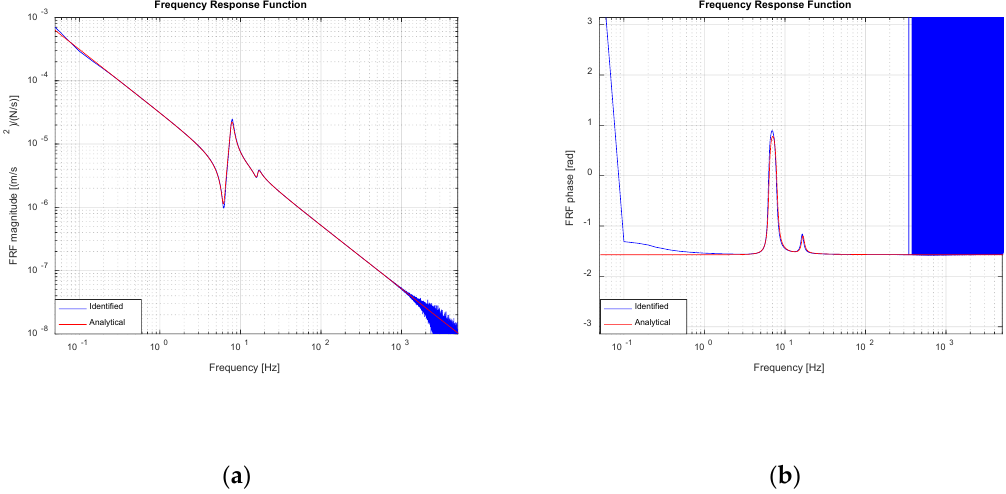
Figure 9. Identified and analytical FRF (noise-free scenario): ( a ) Magnitude; ( b ) Phase.